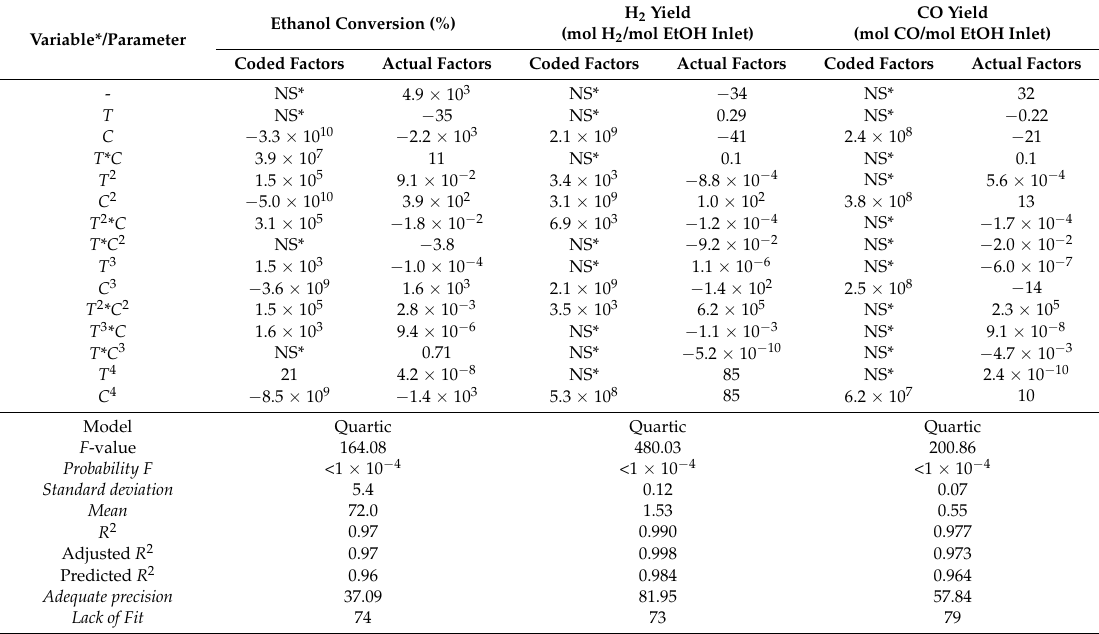
Table 3. Results of regression analysis and the Analysis of Variance (ANOVA) for the model of the experimental data for activity and yield of RhPt/CeO 2 catalysts evaluated in steam reforming of ethanol